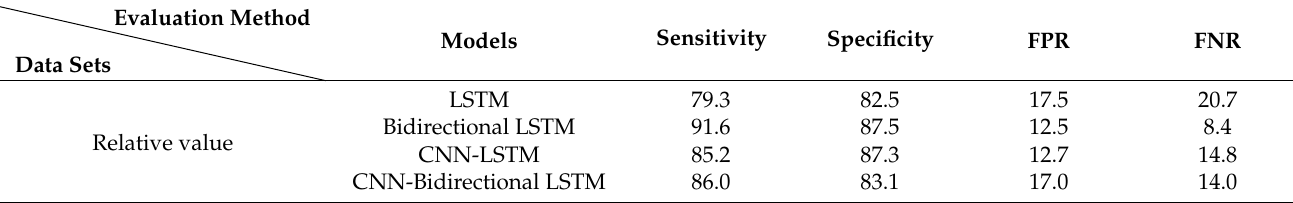
Table 8. DL models’ sensitivity, specificity, FPR, and FNR based on relative values. SetsEvaluation Data